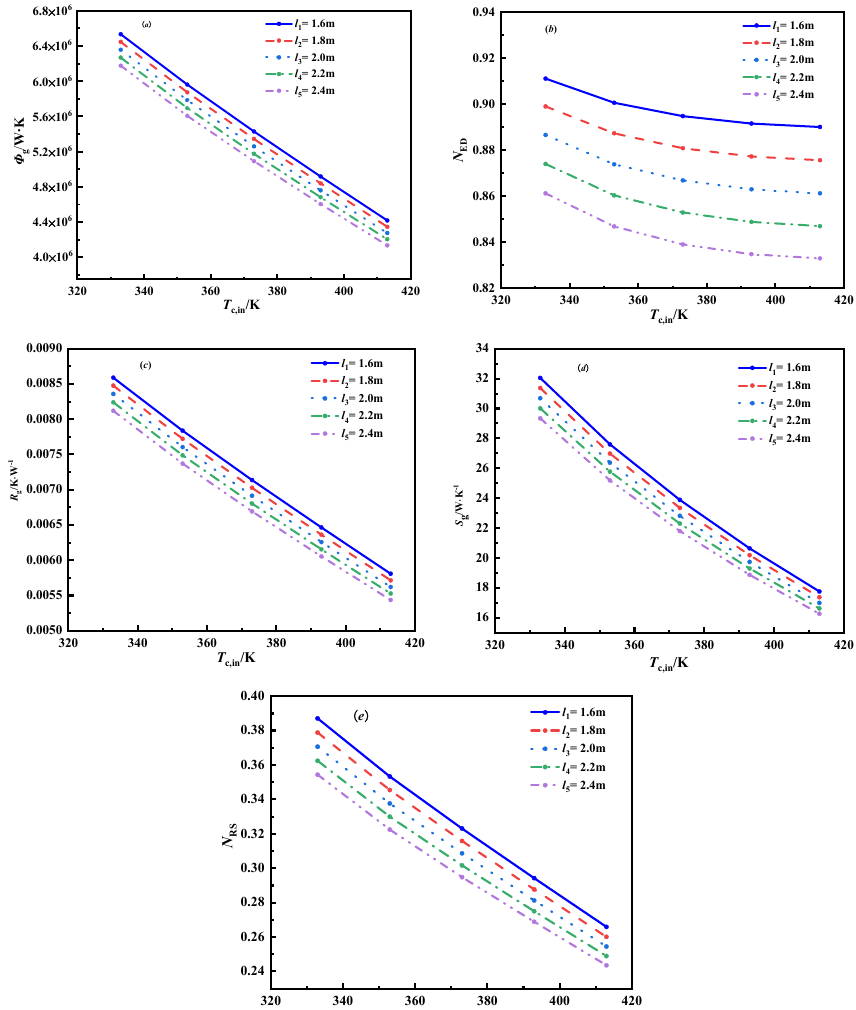
Figure 6. The 𝜙 ( a ), 𝑁 ED ( b ), 𝑅 g ( c ), 𝑆 g ( d ), and 𝑁 (cid:2902)(cid:2903) ( e ) versus the length of the g